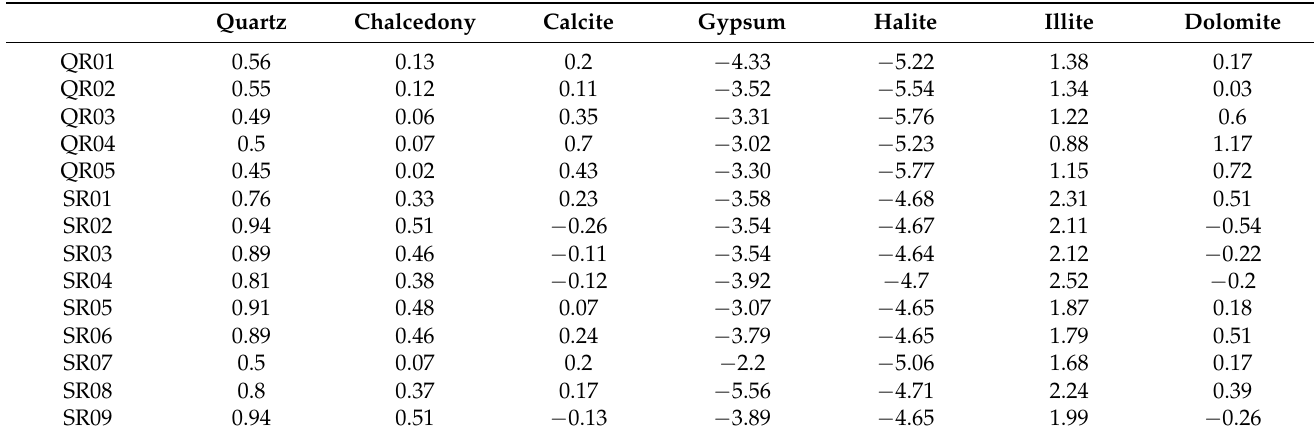
Table 2. Mineral saturation index.